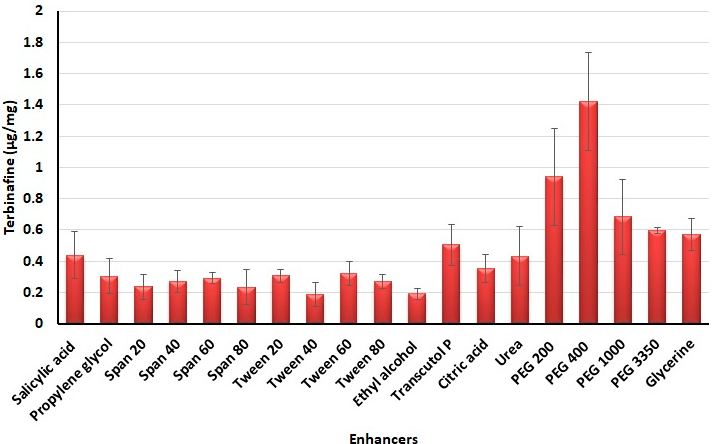
Figure 1. Amount of terbinafine accumulated in nail plates with various enhancers tested. Table 2. Physicochemical characteristics of preliminary batches